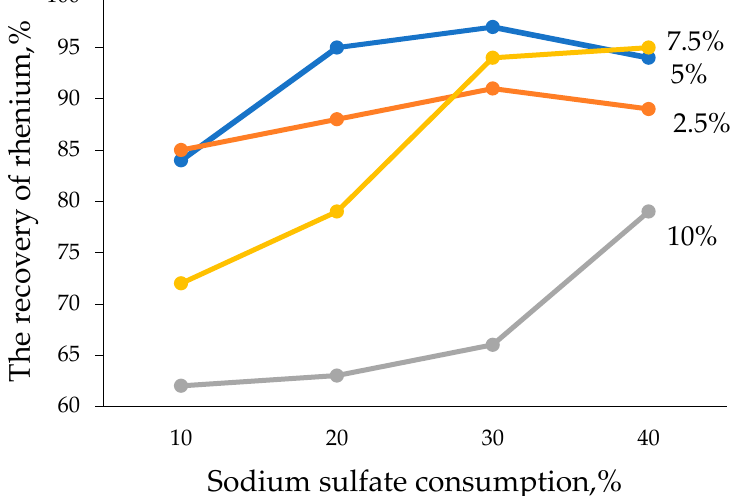
Figure 2. Effect of consumption of sodium sulfate and coke on the degree of extraction of rhenium into slag.